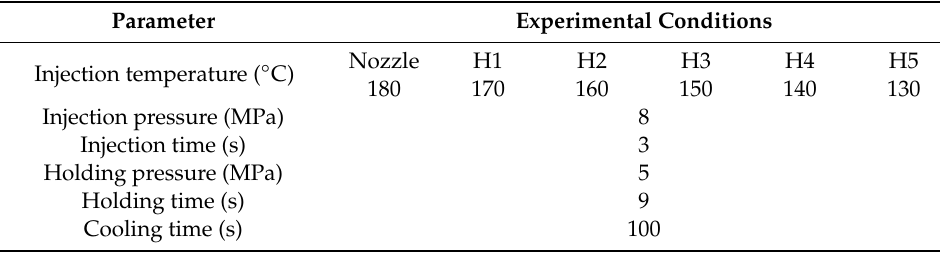
Table 1. Detailed experimental conditions of the injection-molding process for specimen preparation.